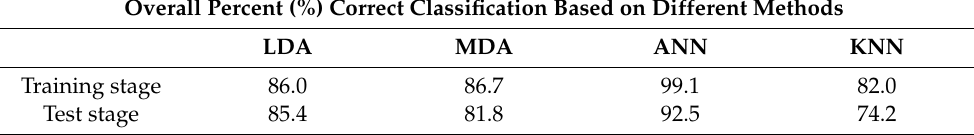
Table 12. Accuracy comparison of classification methods in the training stage and test stage. Overall Percent (%) Correct Classification Based on Different Methods